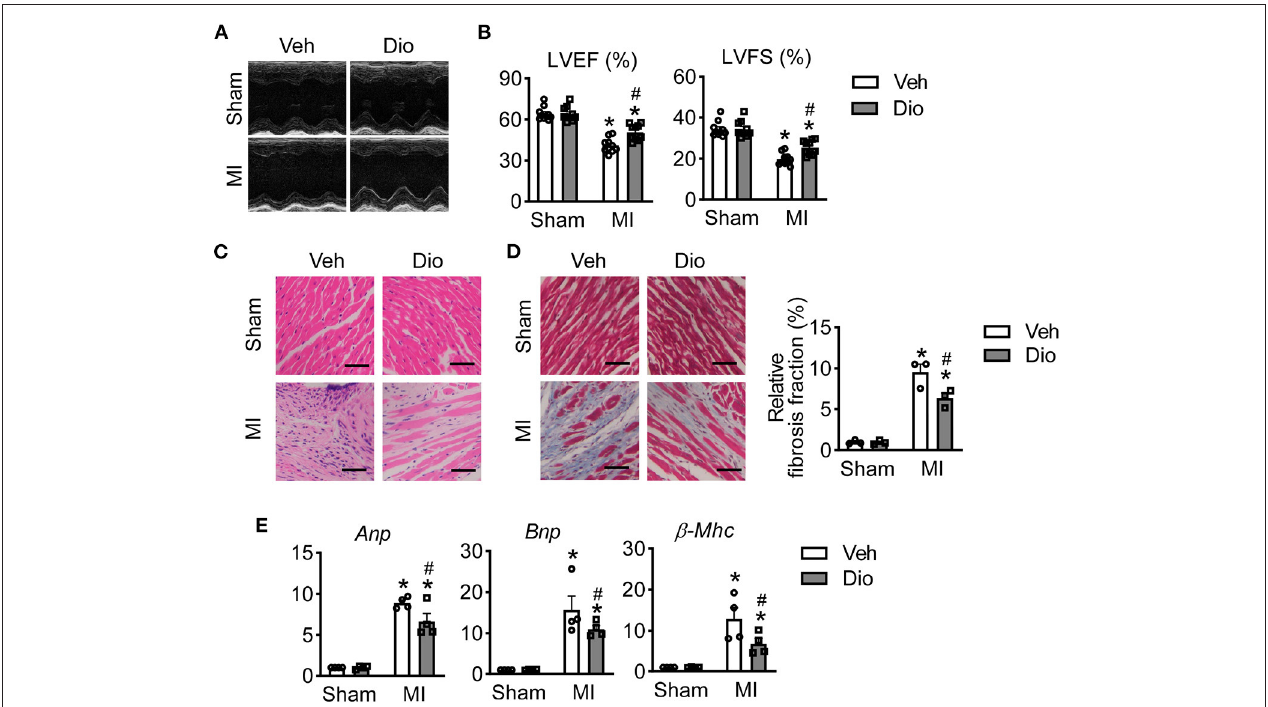
FIGURE 2 | Dioscin protects mice against infarcted injury. (A) Representative images of echocardiographic measurement ( n = 10). (B) Echocardiographic parameters for left ventricular ejection fraction (LVEF, %) and left ventricular fractional shortening (LVFS, %) ( n = 10). (C) Representative images of HE staining, bar = 100 µ m ( n = 3). (D) Representative images of Masson trichrome stained and its quantification, bar = 100 µ m ( n = 3). (E) The mRNA level of heart failure markers for natriuretic peptide A ( Anp ), natriuretic peptide B ( Bnp ) and beta-myosin heavy chain ( β -Mhc ) ( n = 4). Data are mean ± SEM. * P < 0.05 vs. sham group, # P < 0.05 vs. MI